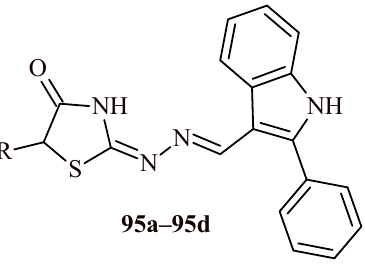
Figure 41. Thiazolidin-4-one-indole hybrids with antitrypanosomal and antileishmanial